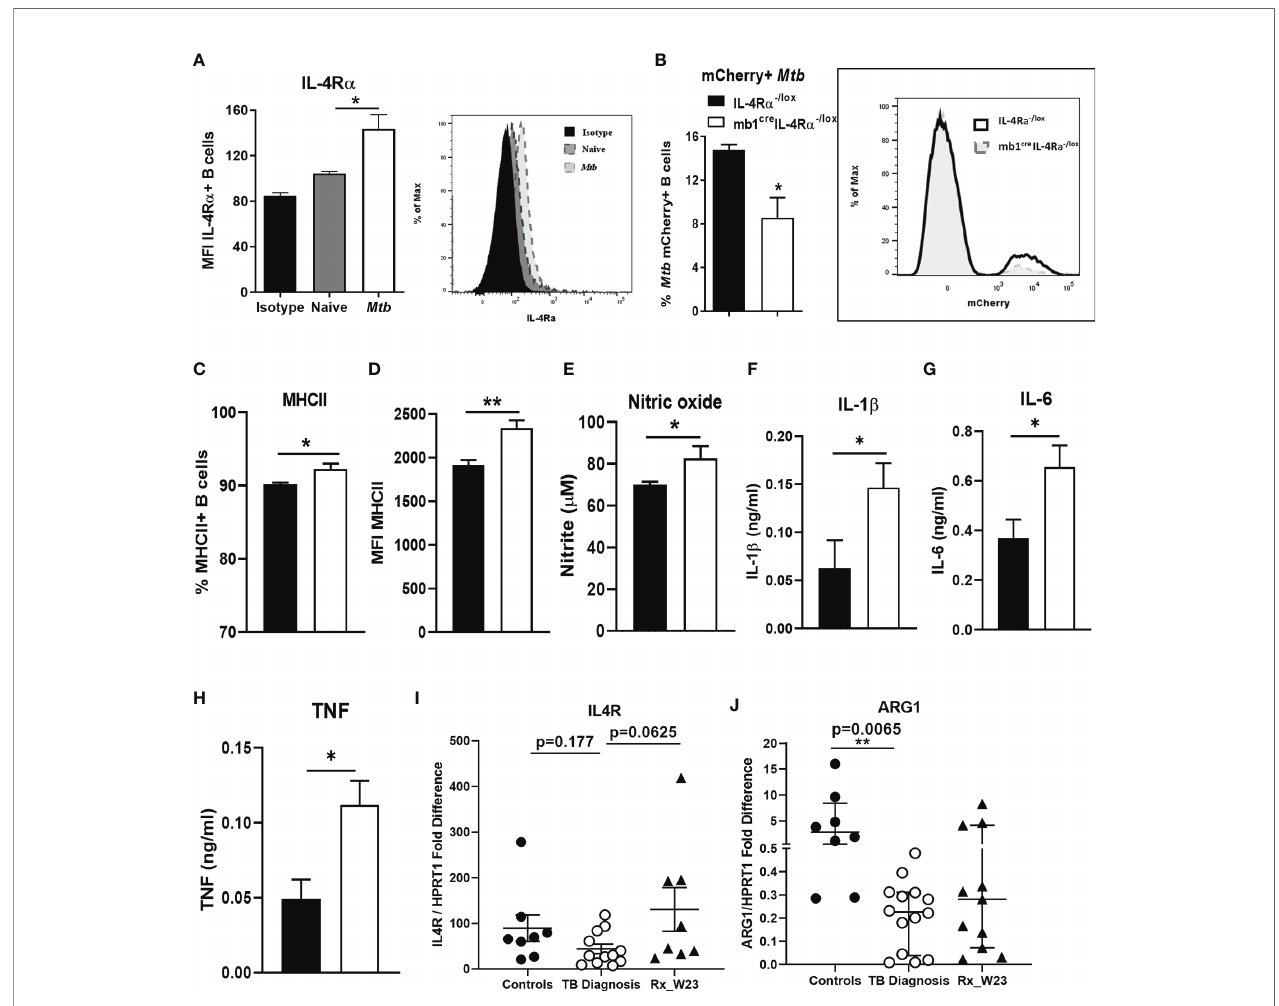
FIGURE 4 | Mtb infection of B cells from mb1 cre IL-4R a -/lox mice induces pro-in fl ammatory responses in macrophages. B cells were puri fi ed by magnetic bead sorting from the spleen of naïve wild-type mice. B cells were then infected with H37Rv Mtb (MOI=2) for 24 hours. (A) IL-4R a surface expression measured in naïve and Mtb exposed B cells by fl ow cytometry. Magnetic bead sorted B cells from IL-4R a -/lox and mb1 cre IL-4R a -/lox mice were infected with mCherry-expressing Mtb for 24 hours. (B) mCherry-expressing Mtb and (C, D) MHC II expression on B cells from IL-4R a -/lox and mb1 cre IL-4R a -/lox mice were analysed by fl ow cytometry. (E) Mtb -infected macrophages were cultured with the supernatants from the Mtb infected B cells for 72 hours. Supernatants were then analysed for the production of (E) nitric oxide, (F) IL-1 b (G) IL-6 and (H) TNF by ELISA. Data are shown as mean ± SEM of n = 3 mice/group and representative of three independent experiments, analysed by unpaired, student t-test versus littermate control, *p < 0.05, **p < 0.01. (I) Human IL4R mRNA and (J) Arginase 1 expression was determined in magnetic bead sorted B cells from healthy, TB patients at diagnosis and after 23 weeks of anti-TB therapy by qPCR with p values between the indicated groups (n=8-12 samples) analyzed by one-way ANOVA, **p < 0.01 versus